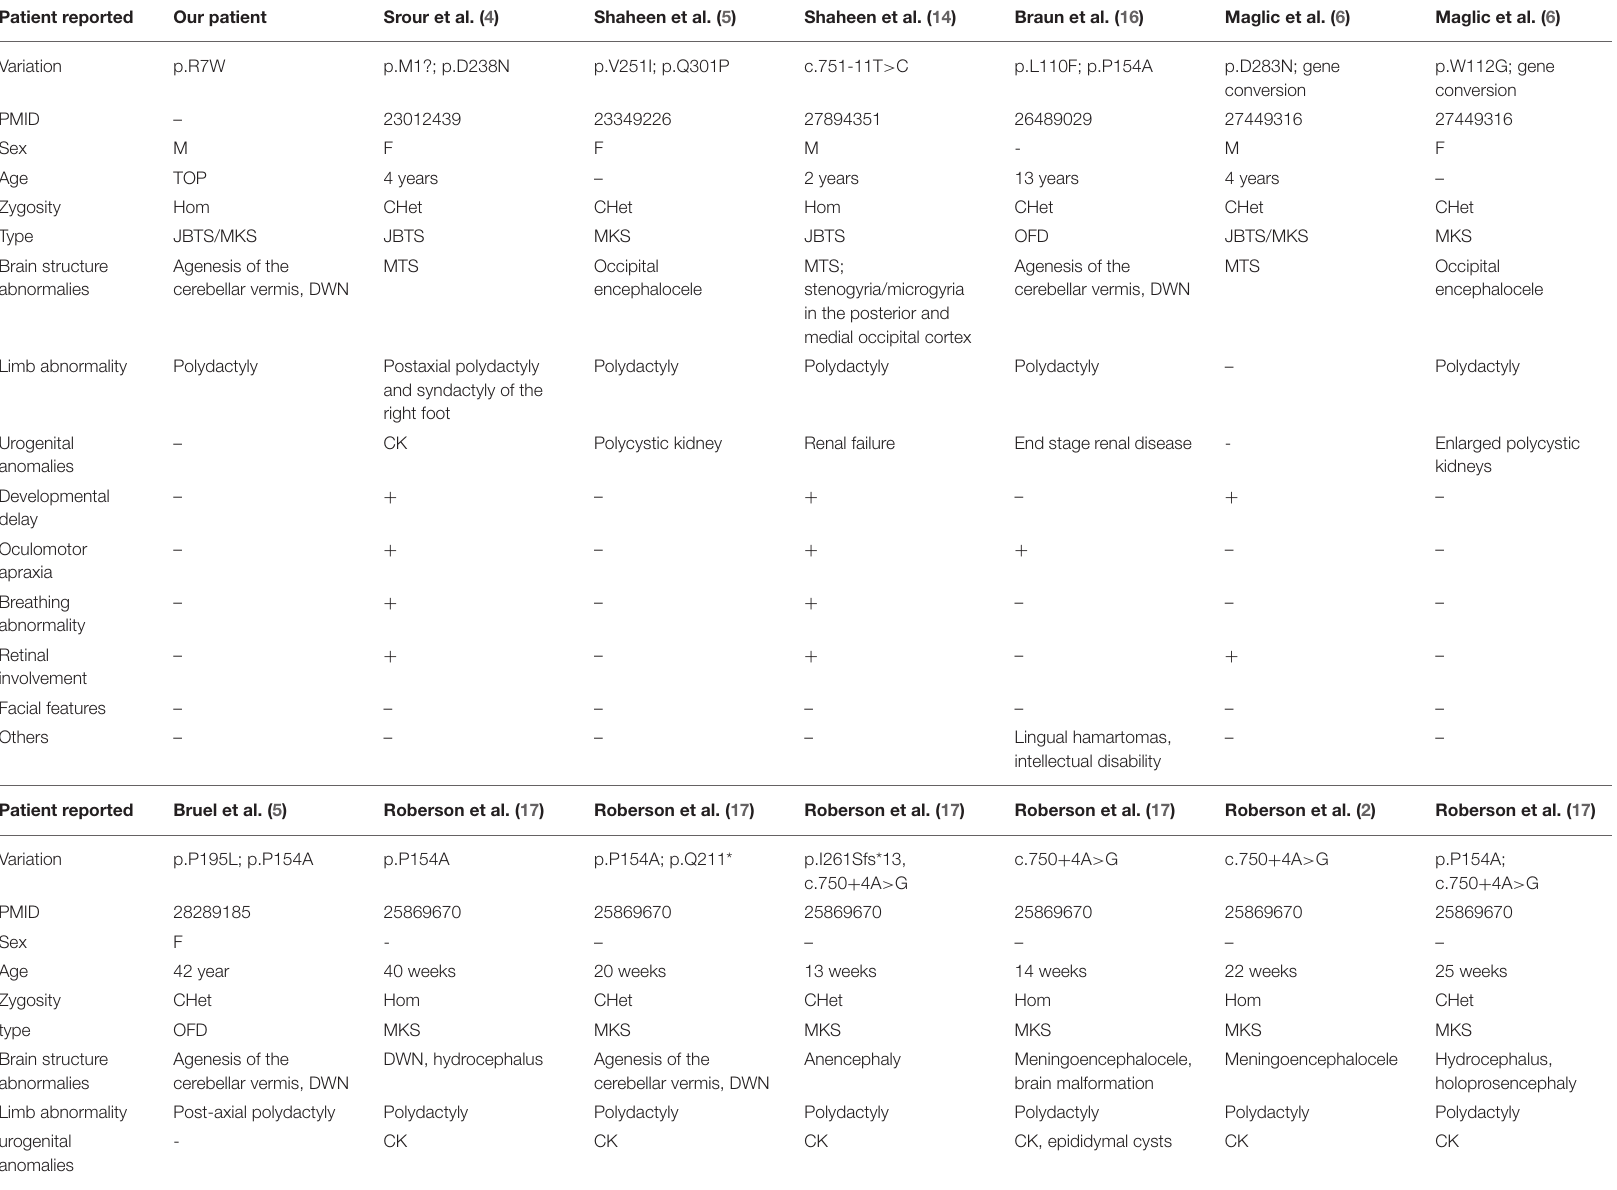
TABLE 3 | The summary of reported patients with TMEM231